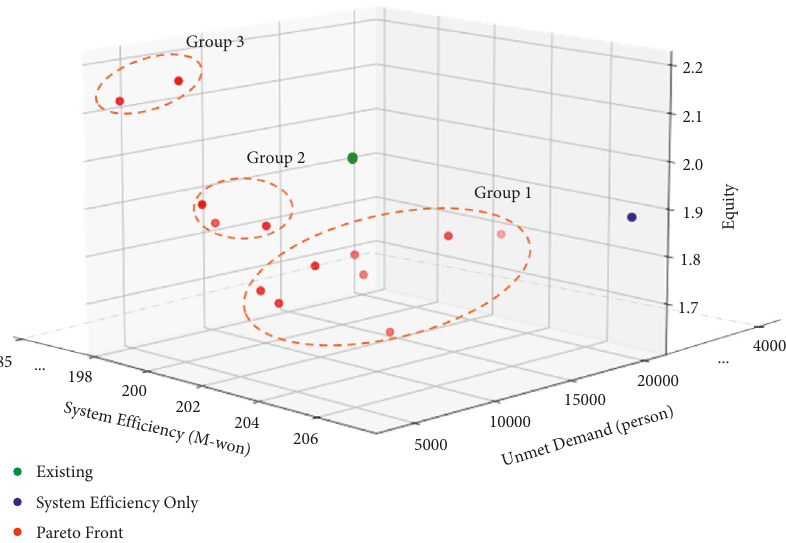
Figure 14: Comparison of the existing network and Pareto optimal solution